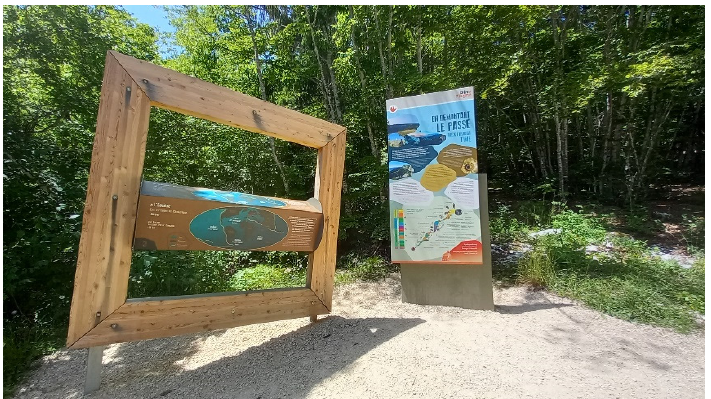
Figure 16. Representation of geological time spans in Dinoplagne (France) (Megerle 2022).